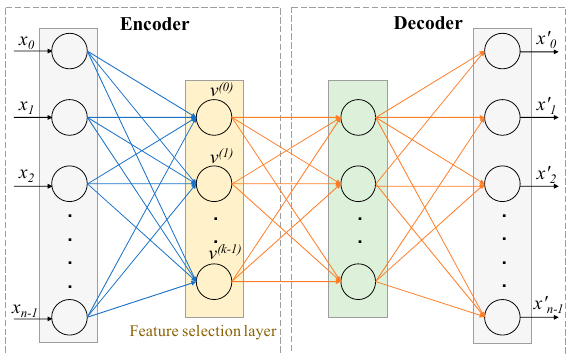
Figure 7. Architecture of Concrete Autoencoder . CAE architecture consists of an encoder and a decoder. The layer after the input layer of the encoder is called the concrete feature selection layer, as shown in yellow. This layer has k number of nodes, where each node is used for each feature to be selected. The decoder is used to check how well the input features can be reconstructed using the selected k features. The output layer has the same number of nodes as the input